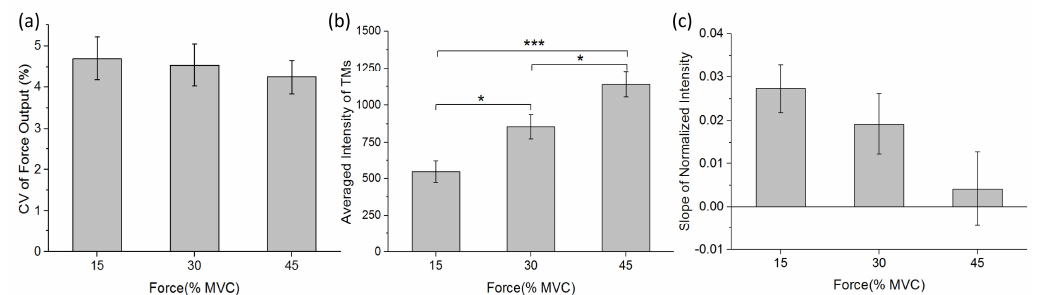
Figure 5. ( a ) The coefficient of variation (CV) of force output at three force levels during sustained constant index finger extension; ( b ) the averaged intensity of 9 TMs at three force levels; and ( c ) the slope of normalized intensity for 9 continuous TMs at three force levels. Asterisks indicate significant difference in multiple compares (* 0.01 < p < 0.05; *** p < 0.005).